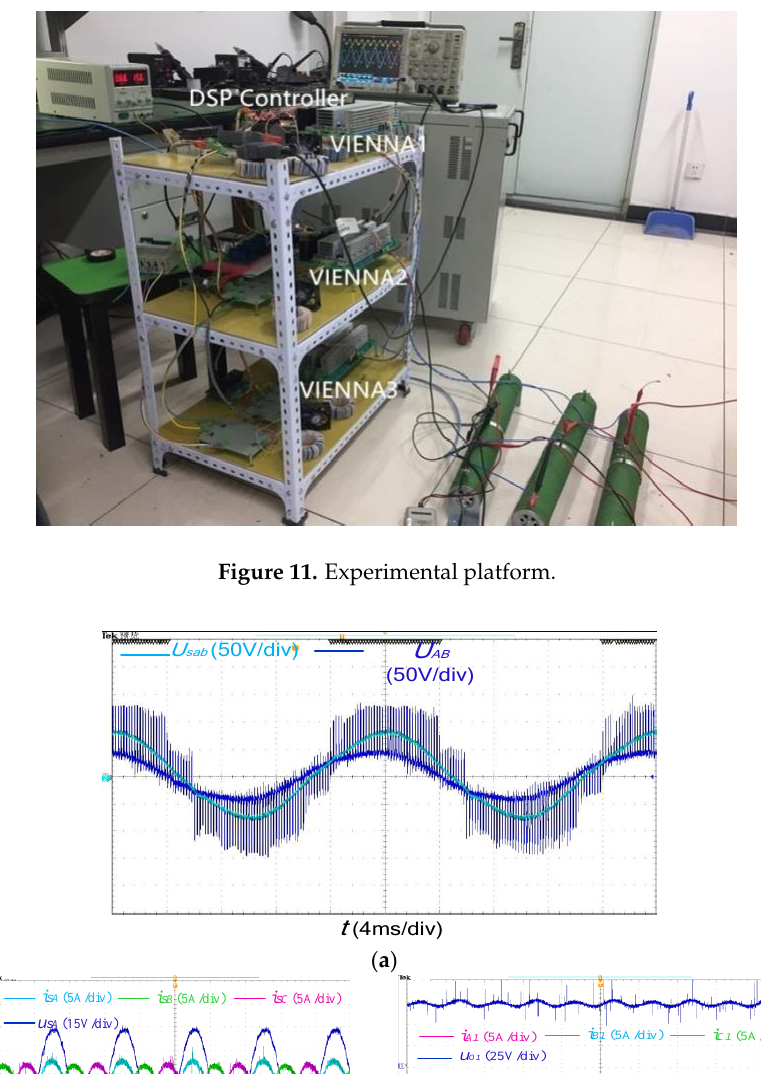
Energies 2018 , 11 , x FOR PEER REVIEW